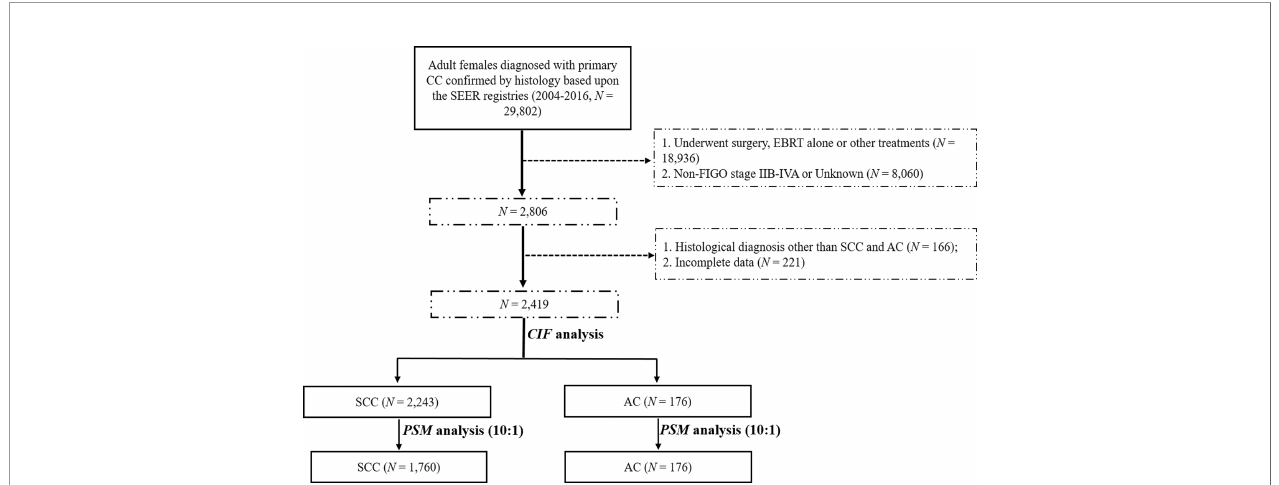
FIGURE 1 | Patient selection fl